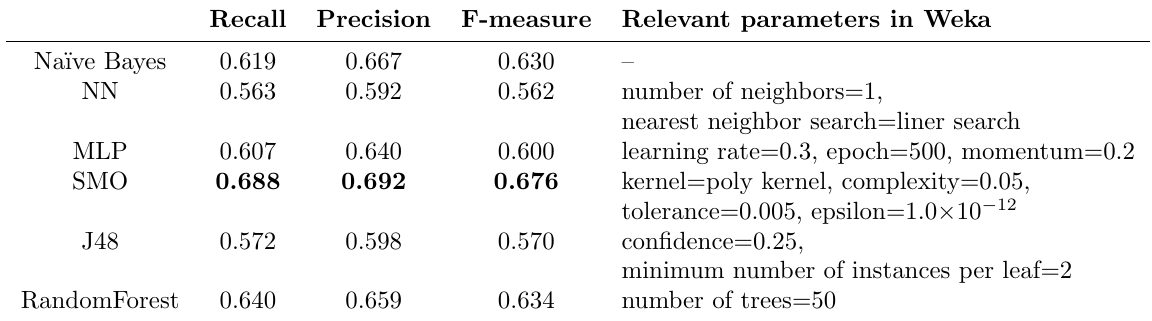
Table 1. Comparison of various supervised classifier approaches using Leave-One-Person-Out cross-validation (LOPO- CV).